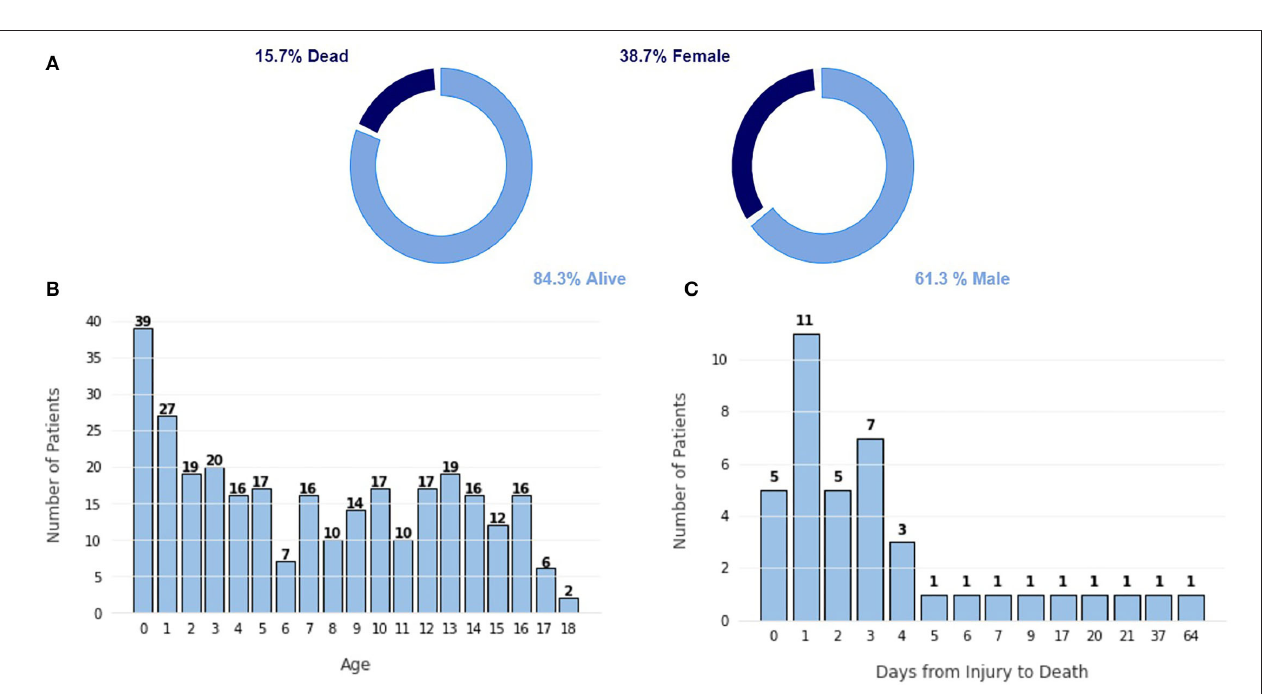
hospitalized pediatric patients, of which 84% are alive, as seen in Figure 2A . Sixty-four percent of the patients are male, and the average age is 7.2 ± 5.5 years, with a median of 6.9 years of